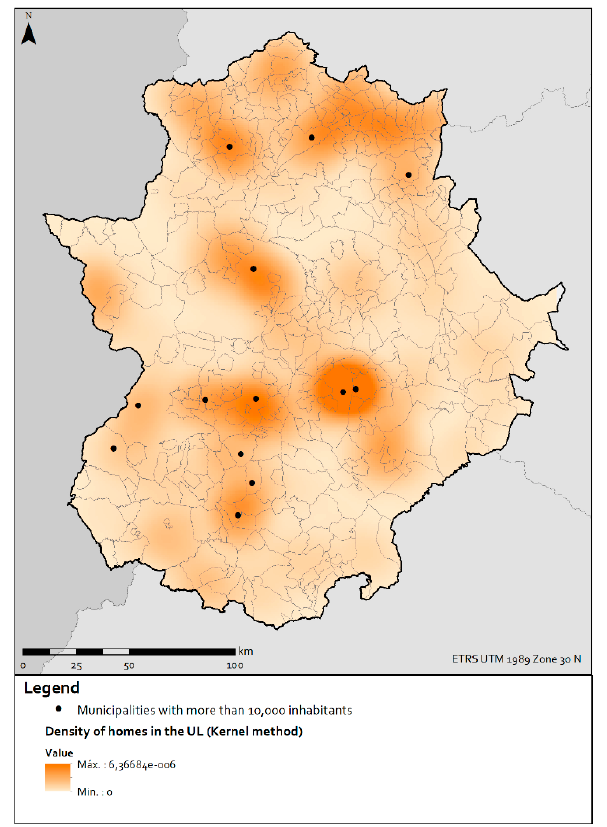
Figure 7. Density of homes on